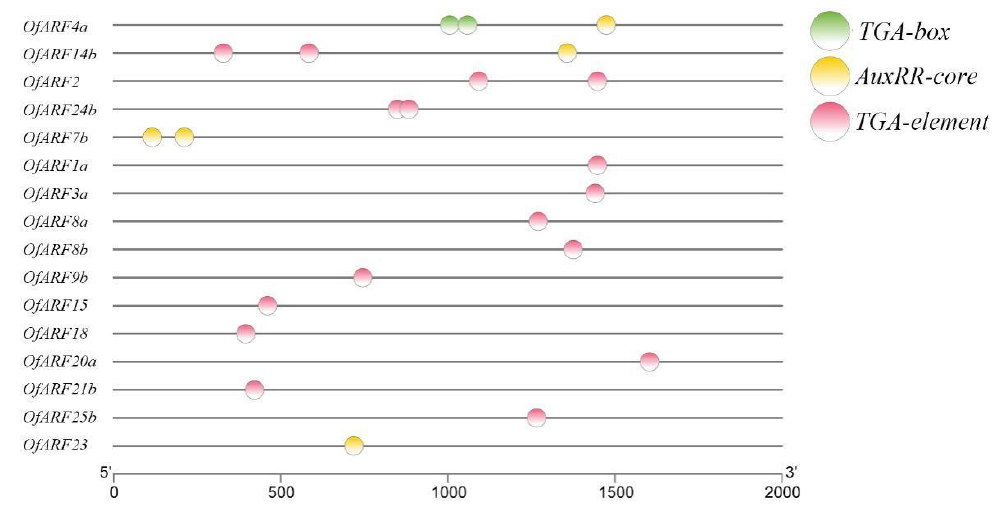
Figure 5. Promoter analysis of Osmanthus fragrans auxin response factor genes ( OfARF s ).